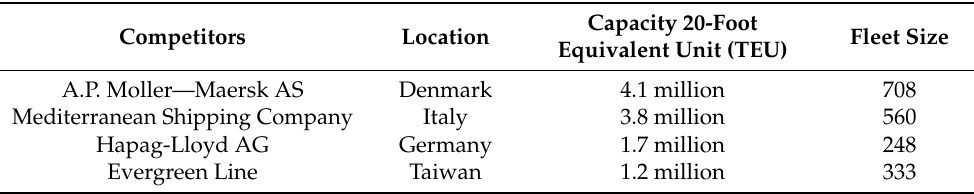
Table 2. Potential competitors/companies to Qatar’s LNG transportation capability (Source: Com- piled by the authors from